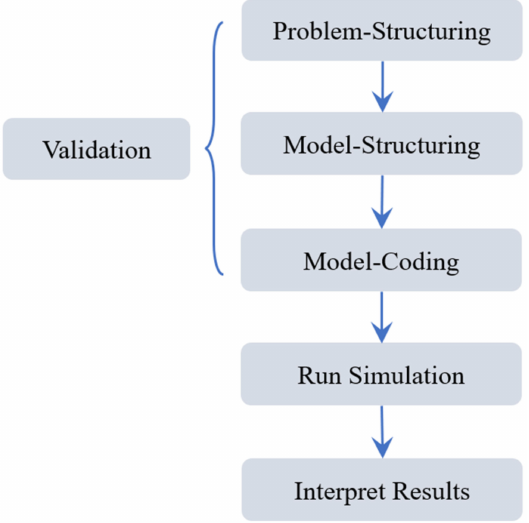
Figure 2. Stages of the simulation model